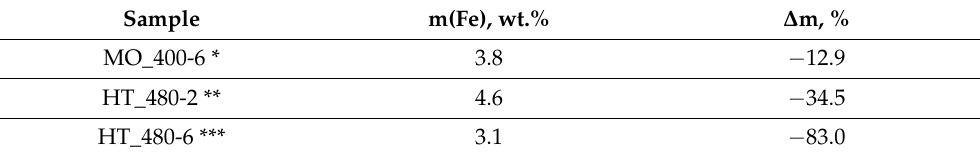
Table 5. Weight losses during purification using wet and dry air with subsequent acid treatment.